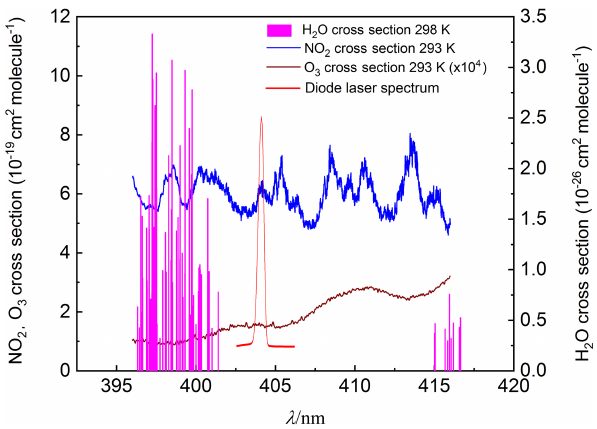
Figure 2. Cross section of the NO 3 radical, NO 2 , O 3 , water vapour and diode laser